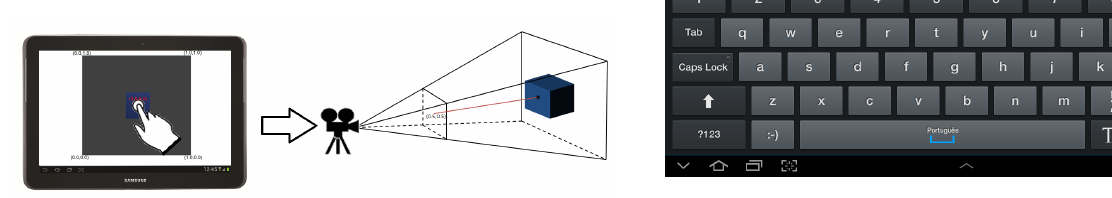
Figure 15. Selection/manipulation of a valve.